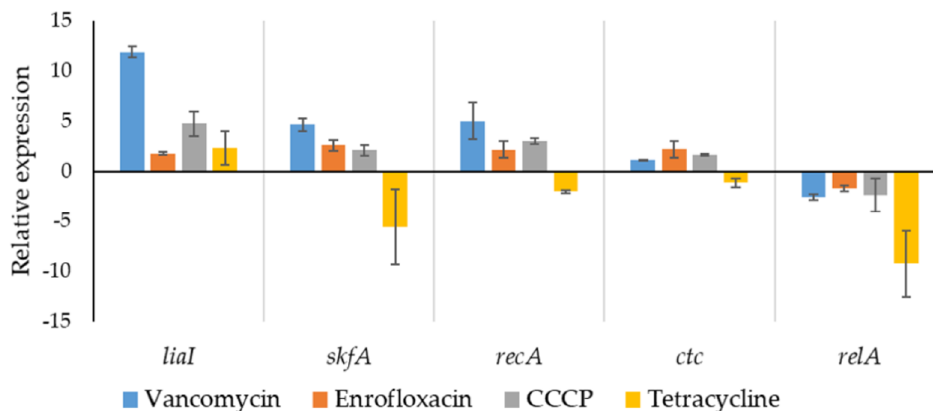
Figure 6. Relative expression level of stress-related genes in isolated persisters. Relative expression of five stress-related genes in isolated persisters generated after treatment with different stressors were determined by qPCR. DNA-binding protein HU1 encoding gene hbsU was used as reference gene. liaI , regulator of cell envelope stress; skfA , regulator of Cannibalism sporulation related stress response; recA , regulator of SOS response; ctc , regulator of general stress response; and relA , regulator of stringent response. n = 3.